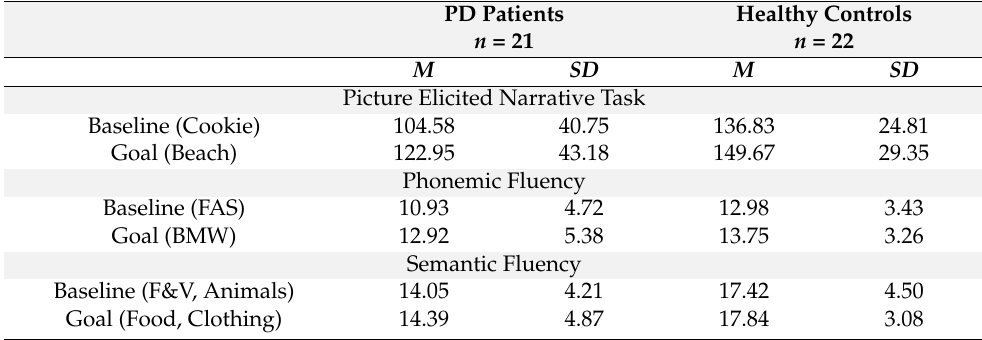
Table 5. Language generation tasks: Number of words produced in 1 min for the baseline and goal Intervention for PD patients and controls.